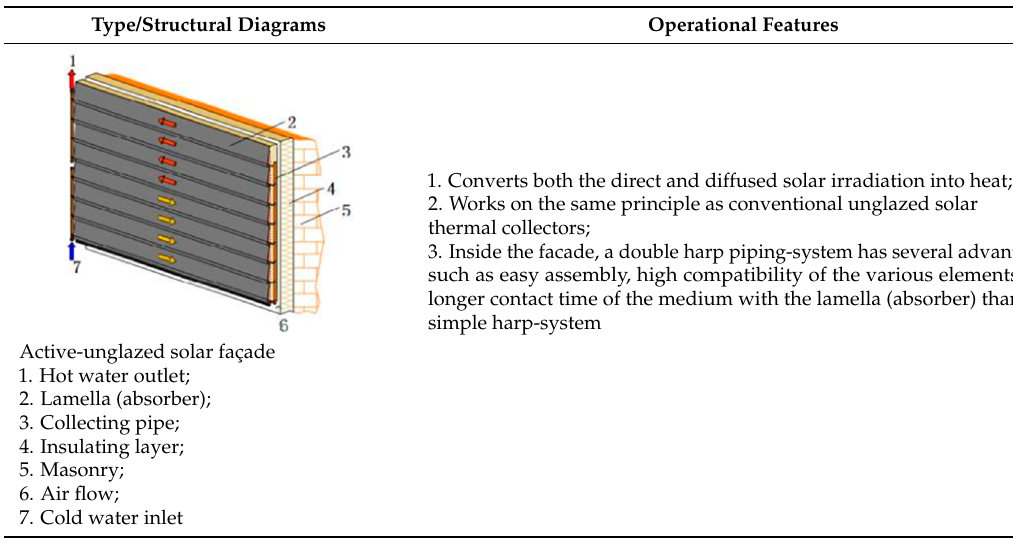
Table 1. Schematic diagram of solar thermal utilization module system and building.